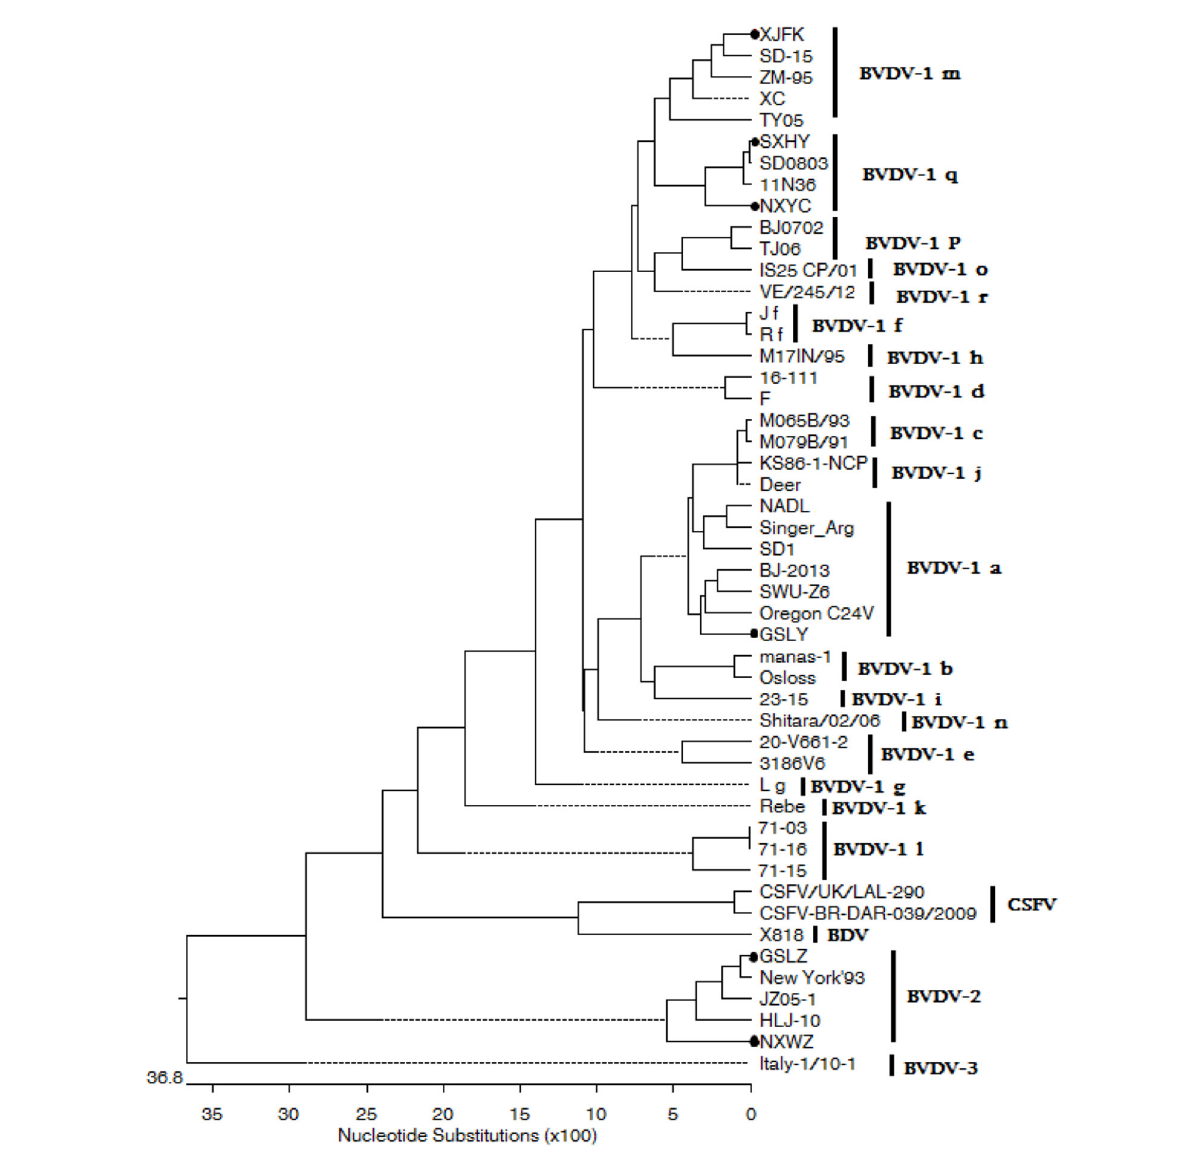
FIGURE5 The phylogenetic tree based on 5 ′ -UTR of BVDV strains. The evolutionary history was inferred using the neighbor-joining method. The sequences of GSLY, GSLZ, SXHY, XJFK, NXYC, and NXWZ isolates were determined in this study; sequences of other strains were obtained from